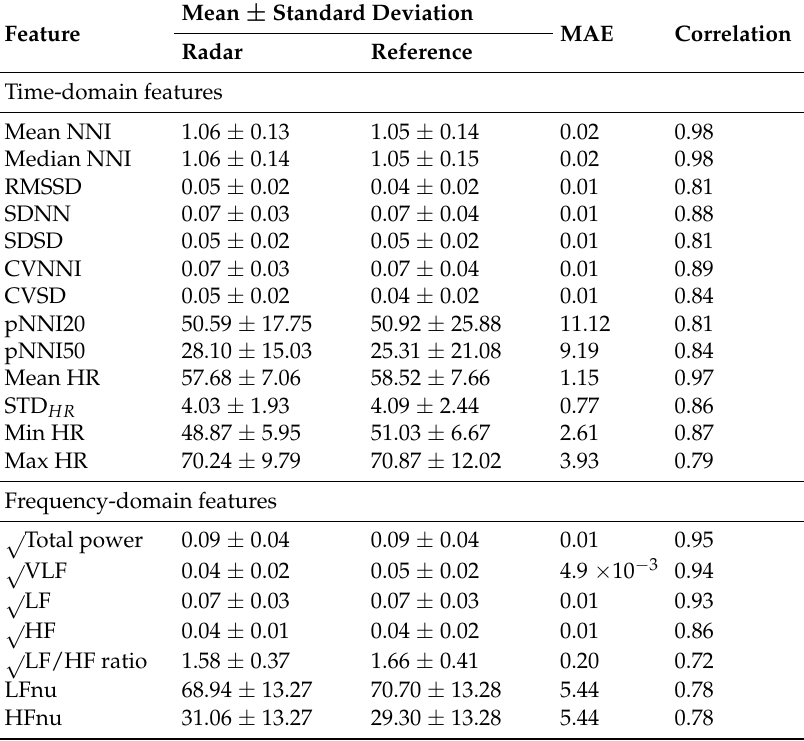
Table 5. Comparison of the heart rate variability